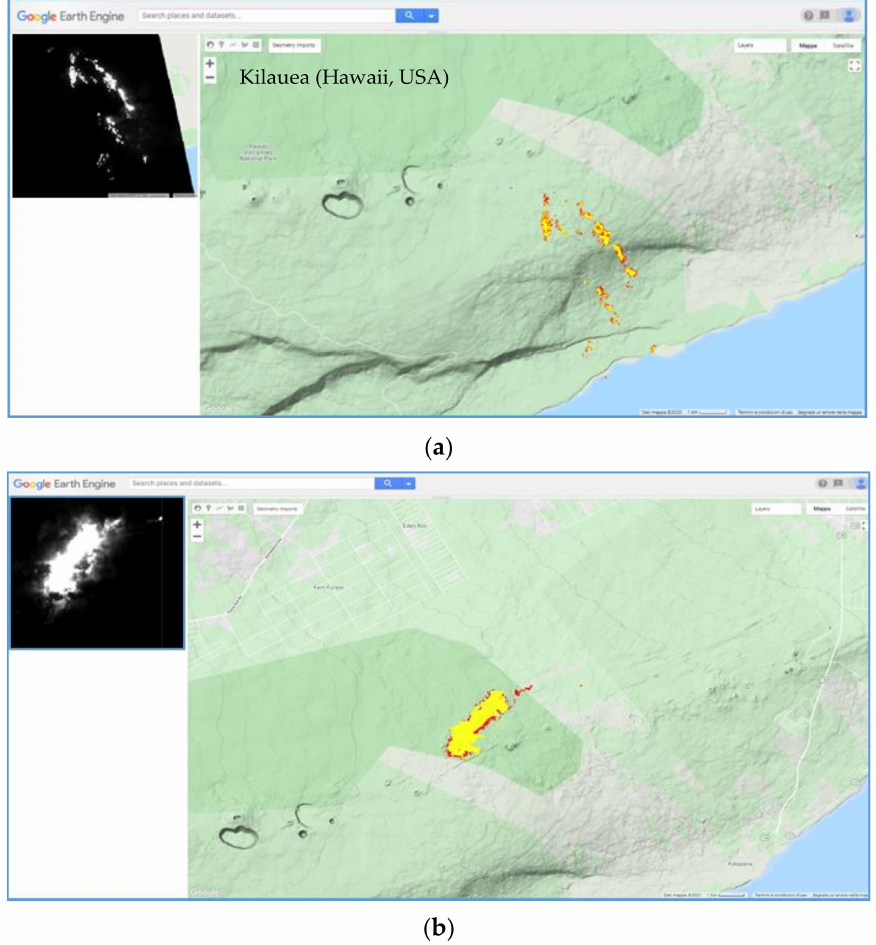
Figure 5. Thermal anomalies (red/yellow pixels) detected by NHI on ASTER data of March 2000–2008, overlapped onto the topographic map of Kilauea; ( a ) 20 February 2005 at 22:41 UTC; ( b ) 21 August 2007 at 22:42 UTC. On the left top, shortwave infrared (SWIR2) band 5 image whose bright pixels indicate hot